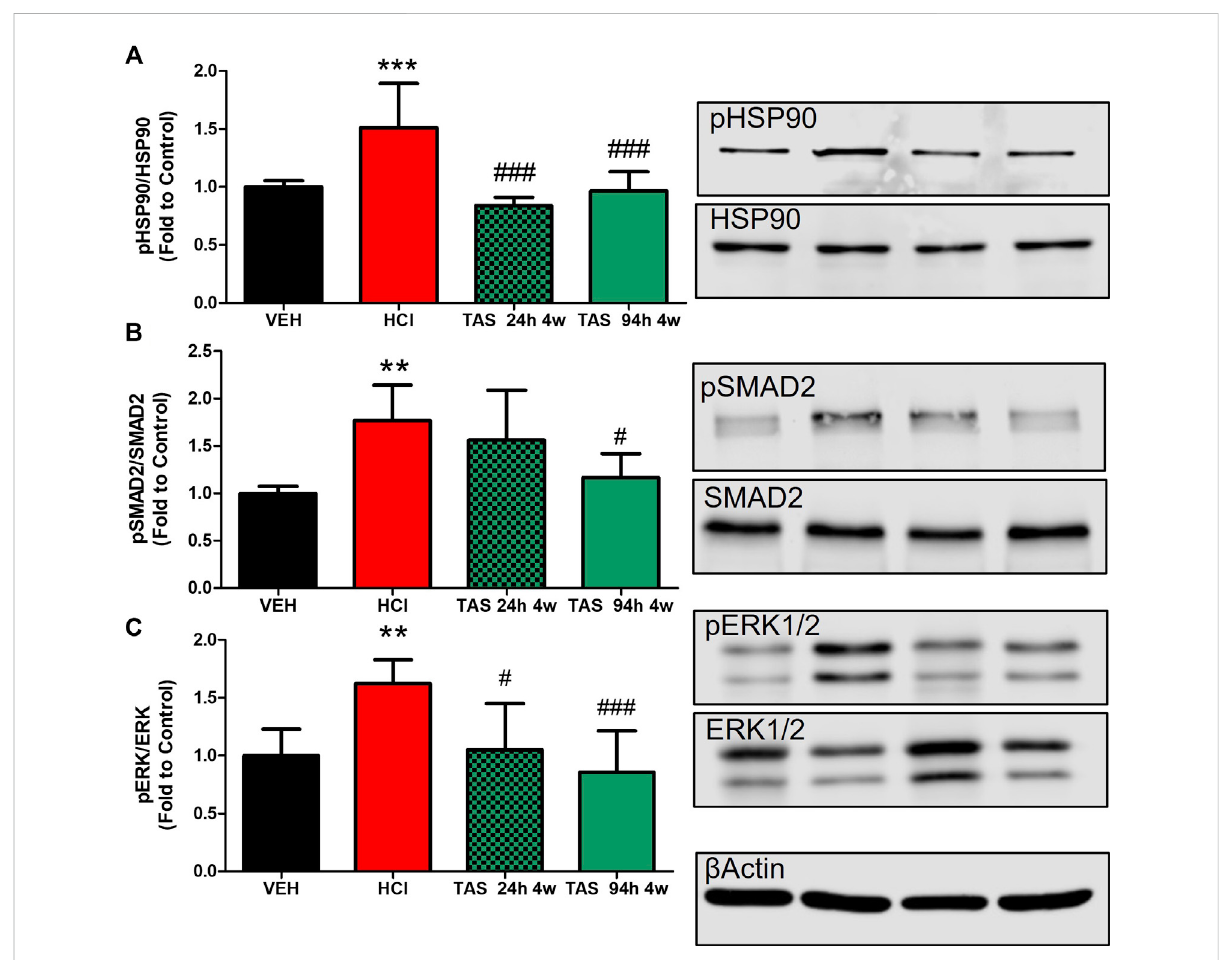
Oral treatment with TAS-116 — starting either 24 or 96 h after HCl-ameliorates HCl-induced activation of pro- fi brotic pathways. (A) HSP90 activation(pHSP90) increased inHCl-instilledmice and was reduced in mice treated with TAS-116 24 hor 96 h postHCl. (B) Phosphorylated SMAD2 was signi fi cantly increased in mice instilled with HCl and reduced in group of mice, receiving treatment 96 h post instillation. (C) ERK1/2 (MAPK) activation (pERK) increased in HCl-instilled mice and reduced in both TAS-116-trated groups. Means ± SEM; ***: p < 0.001, **: p <